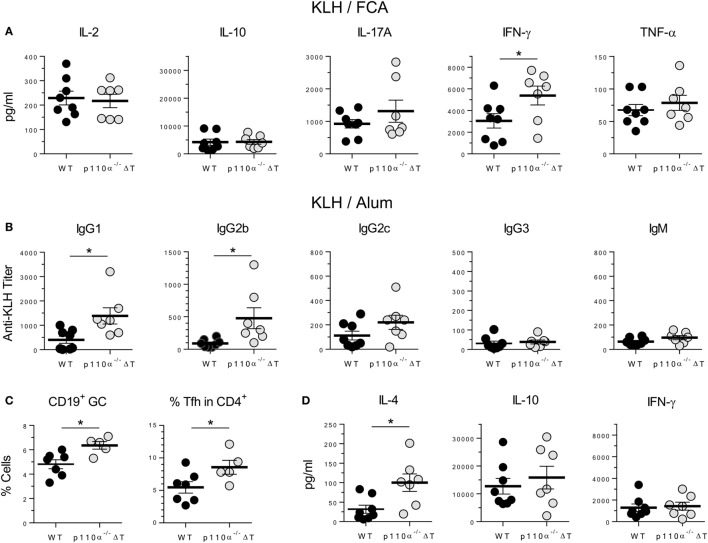
T-cell PI3-kinase p110α deficiency alters cytokine and antibody responses against the protein antigen keyhole limpet hemocyanin (KLH). (A) WT (n = 8) or p110α−/−ΔT mice (n = 7) were immunized s.c. with KLH plus FCA. Lymph node cells from individual mice were taken on day 7 after immunization, and cultured “in vitro” for further 96 h in the presence of KLH. Then, cytokines in the supernatant (IL-2, IL-10, IL-17A, IFN-γ, or TNF-α) were determined, as indicated in the figure. Individual values as well as means ± SE are shown. Data from two experiments. Significant differences (*p < 0.05) are indicated, as determined by the Student’s t-test. (B) KLH-specific response of WT or p110α−/−ΔT mice injected i.p. with KLH in Alum: antibodies of the IgG1, IgG2a, IgG2c, IgG3, and IgM isotypes were determined in the serum 10 days after immunization. (C) Percentage of germinal center B cells (CD19+PNA+) and Tfh cells (CD4+CXCR5+ICOS+) were determined in the spleen of KLH/Alum immunized mice. (D) Spleen cells from immunized mice were cultured “in vitro” for 96 h in the presence of KLH, and cytokines in the supernatant (IL-4, IL-10, IFN-γ) were determined. Data from one (C) or two experiments (B,D). Individual values from n = 8 (WT) or n = 7 (p110α−/−ΔT) mice (B,D), or n = 7 (WT) and n = 5 (p110α−/−ΔT) mice (C), as well as means ± SE, are shown. Significant differences (*p < 0.05) are indicated, as determined by the Student’s t-test.